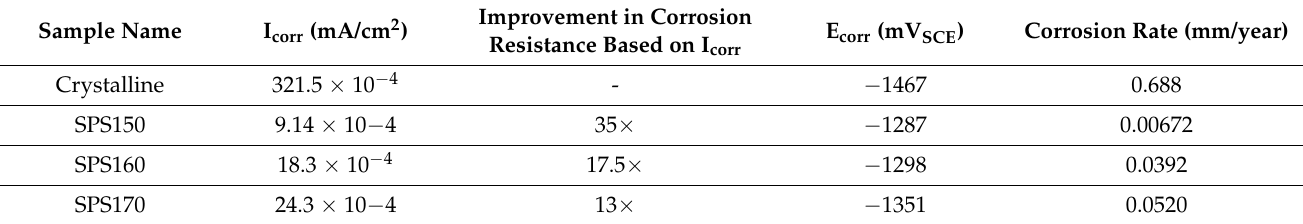
Table 4. Comparison of I corr and E corr between Mg-Zn-Ca across various sintering temperature compared to